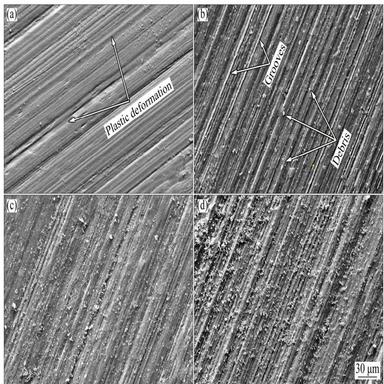
FESEM micrographs of worn surface of Ti−6Al−4V alloy (a) and composite coatings at different rotational speeds (b−d): (b) 600 r/min; (c) 800 r/min; (d) 1000 r/min